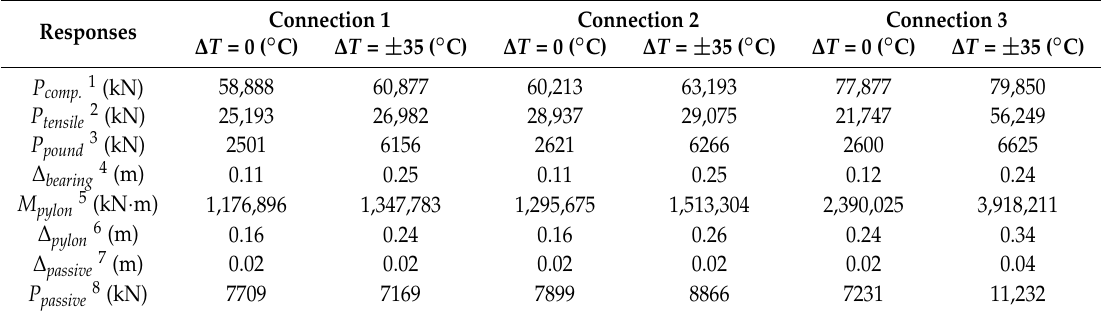
Table 5. Seismic responses of the bridge for different deck to pylon connections with temperature changes of ± 0 ◦ C and ± 35 ◦ C, respectively.